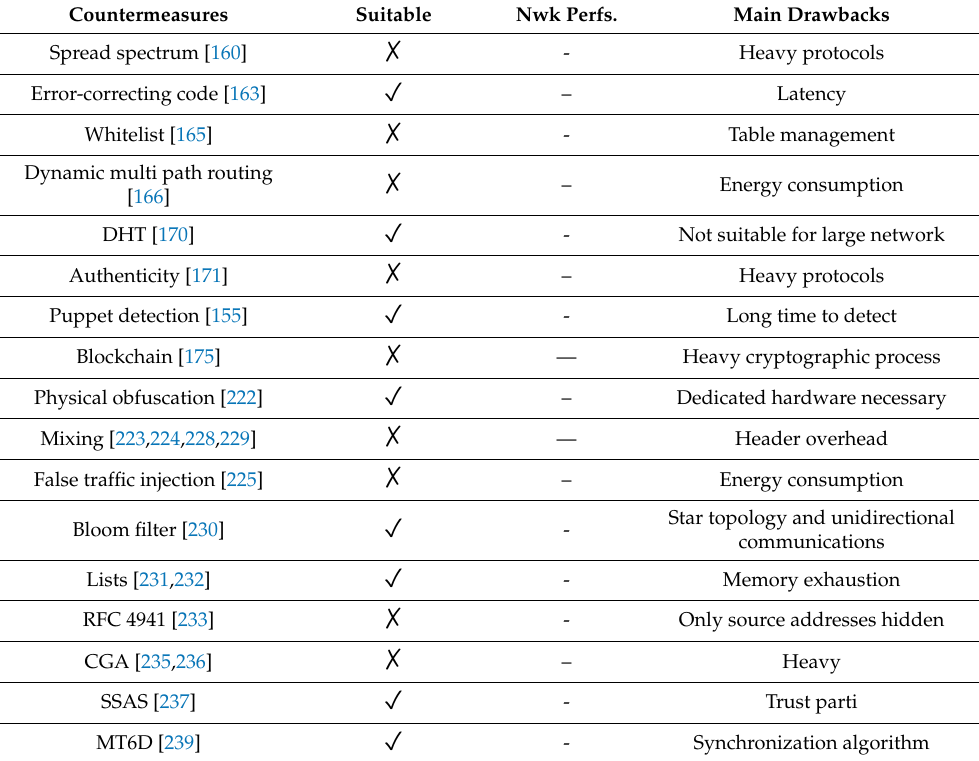
Table 5. Comparison of the proposed countermeasures. Countermeasures